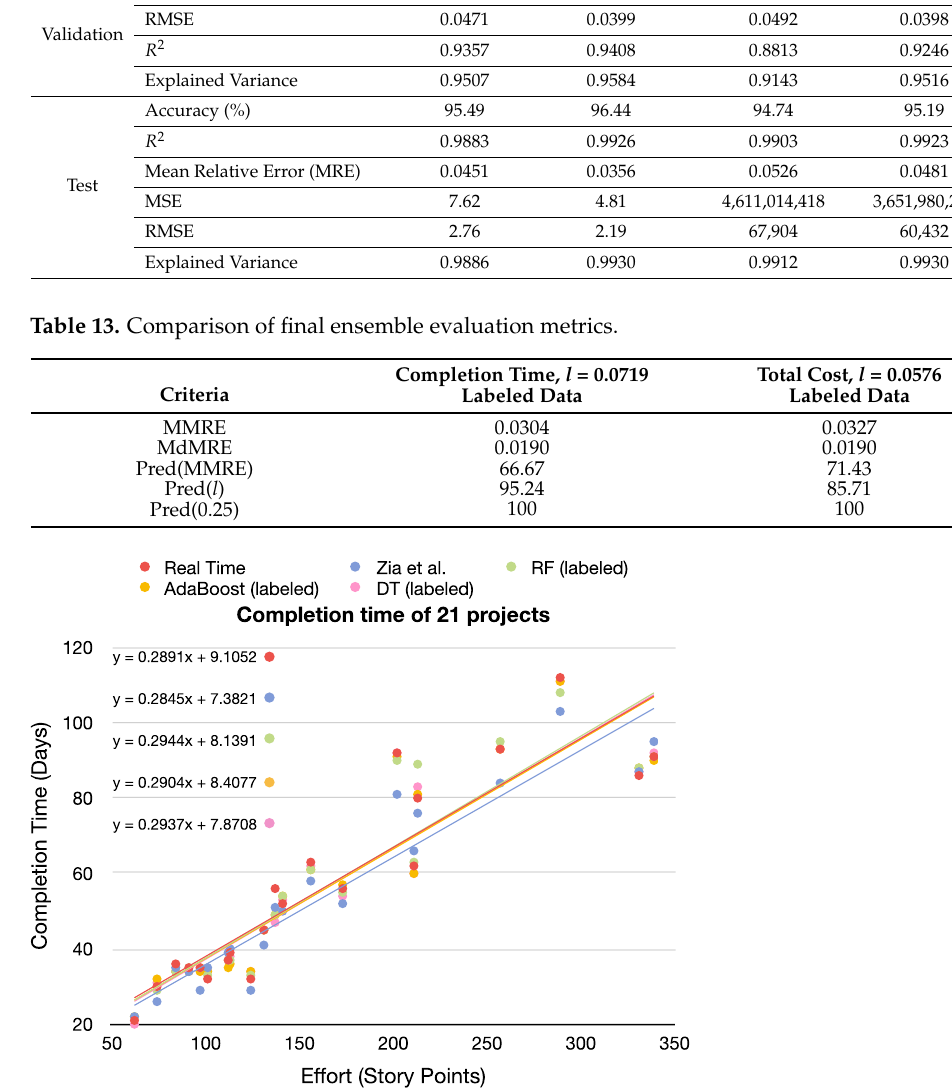
Figure 9. Regression lines for the three machine learning techniques , the real project values and the original model (Zia et al. [31]) when predicting completion time